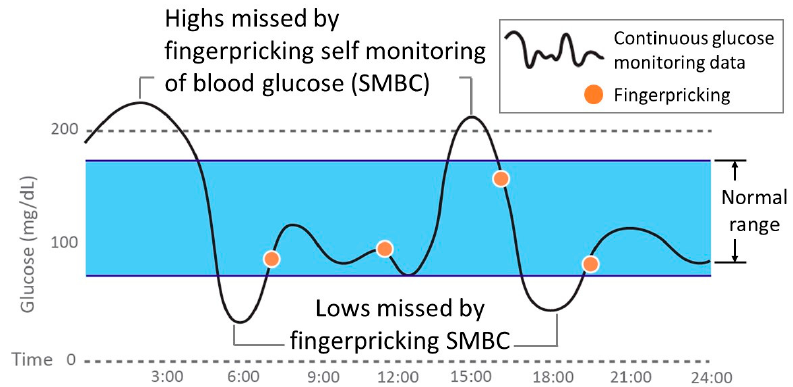
Figure 1. Comparison of finger-pricking self-monitoring of blood glucose (SMBC) and continuous glucose monitoring (CGM).